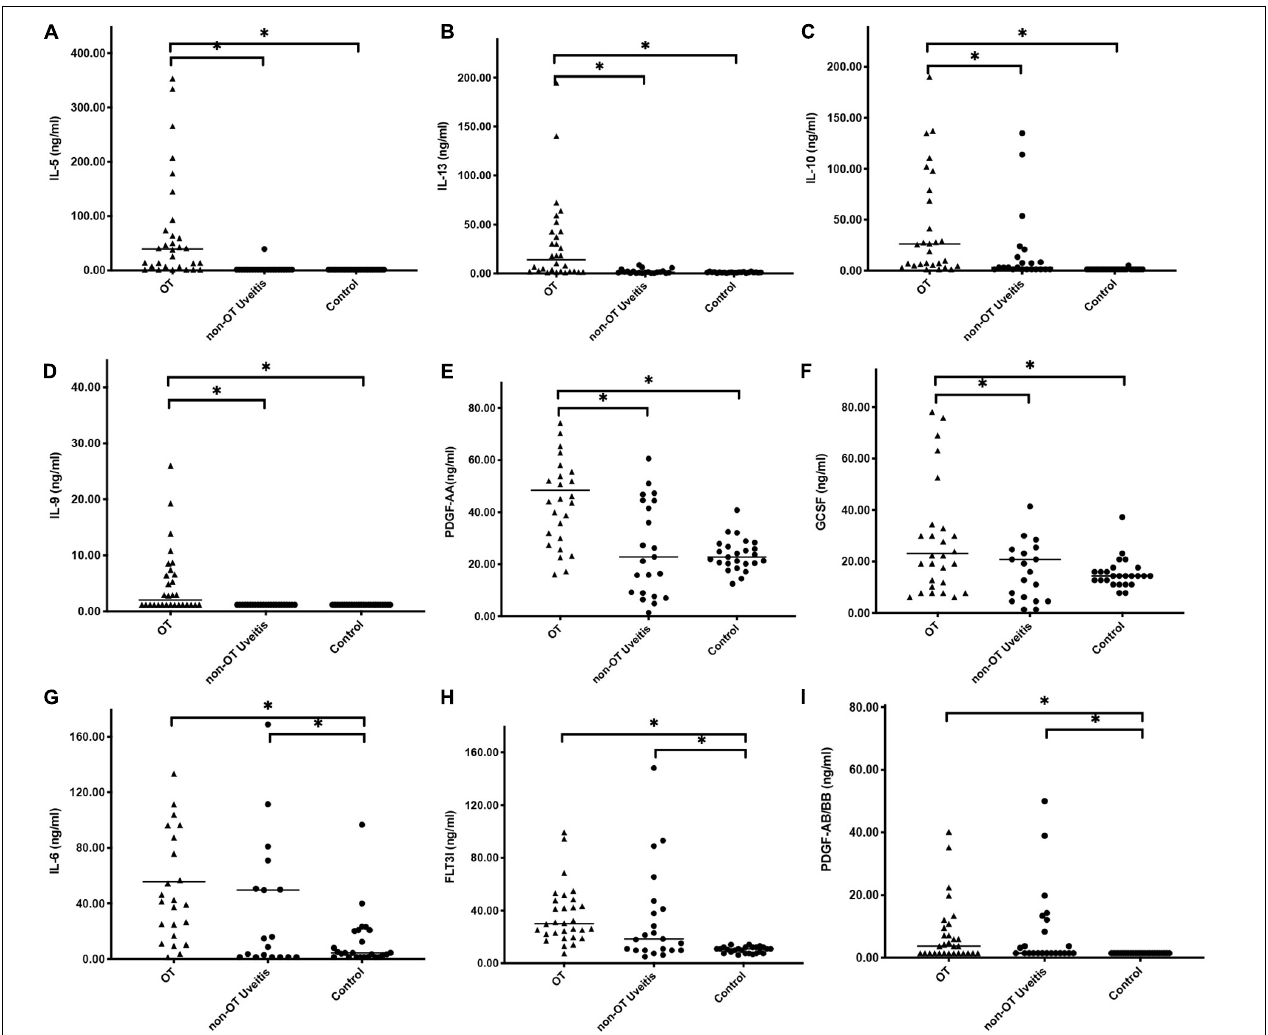
FIGURE 2 | Scattered distribution of representative cytokines concentration among three groups. Between 31 cytokines, expressions of IL-5, IL-10, IL-13, IL-9, and PDGF-AA were significantly increased in OT group alone, when compared with uveitis and control group (A–F) . IL-6, FLT3L, and PDGF-BB also showed significant differences between OT and control groups (G–I) , but there were no significant differences between OT and uveitis groups. * P <